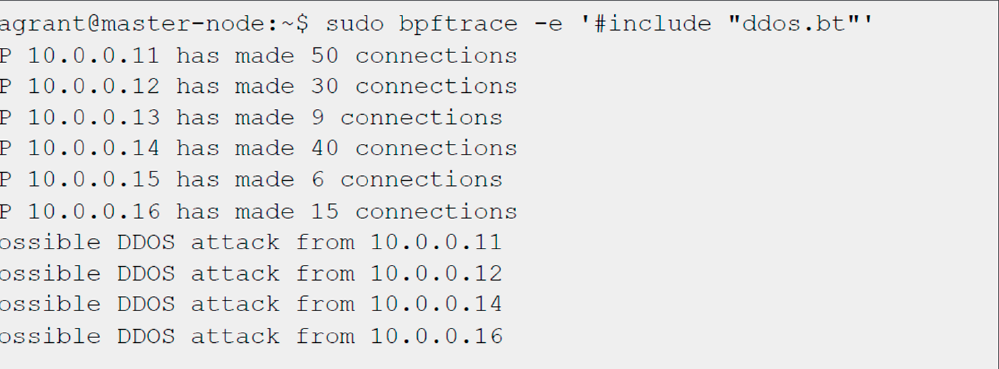
Figure 2. Detection of the Attack on the target node.